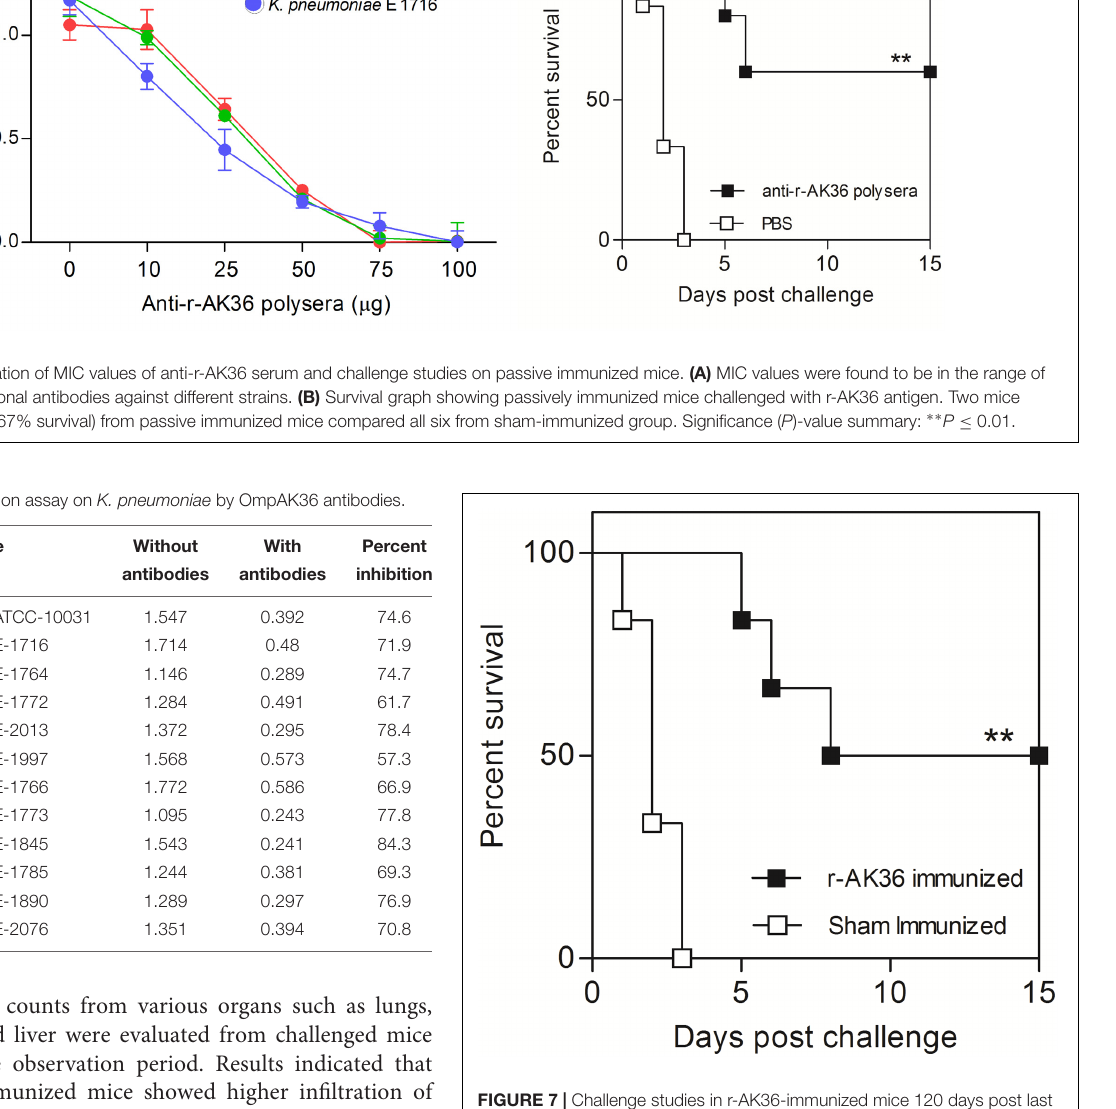
FIGURE 7 | Challenge studies in r-AK36-immunized mice 120 days post last immunization. Three mice succumbed to death (50% survival) in active immunized mice while no survivors were observed in sham-immunized group of mice. Significance ( P )-value summary: ∗∗ P ≤